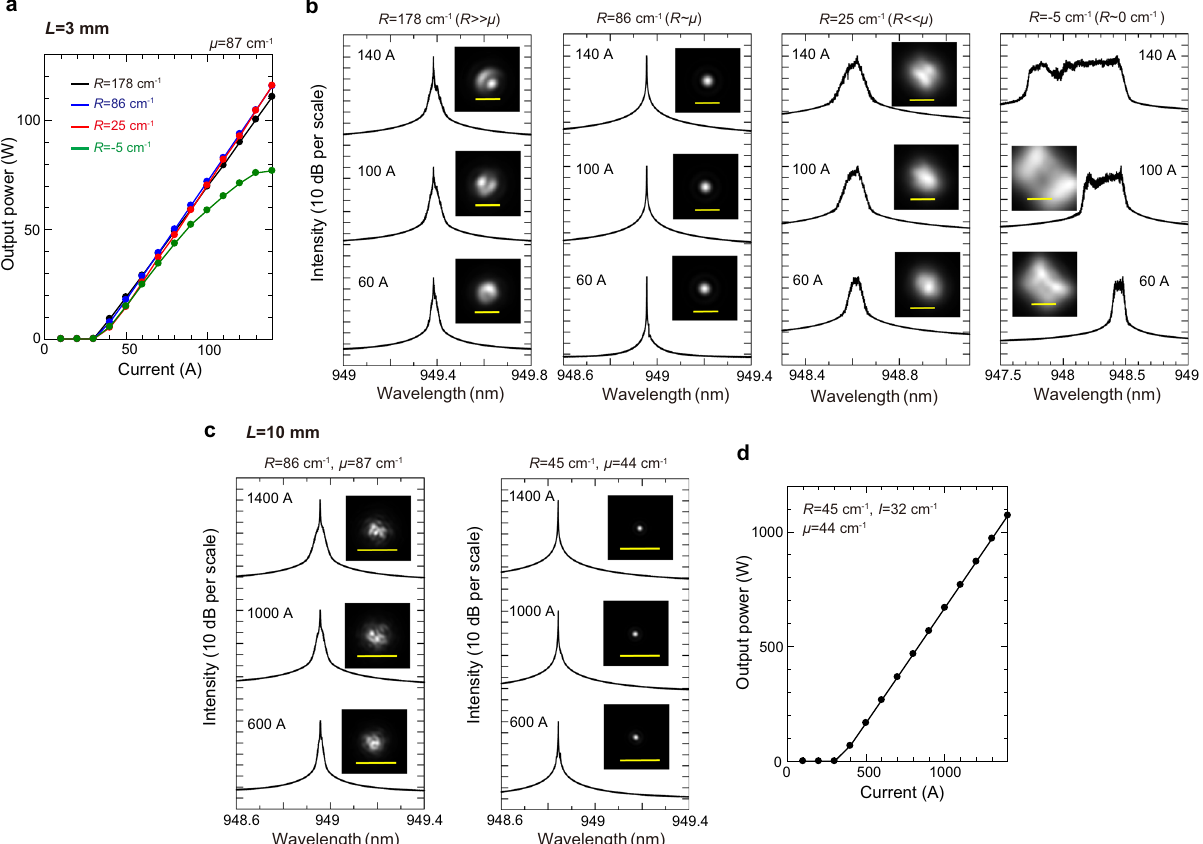
Fig. 6 Numerical demonstration of single-mode lasing in ultra-large-area PCSELs with controlled coupling coef fi cients. a Calculated I - L characteristics of 3-mm-diameter PCSELs with four different lattice separations d or the real part of phase-invariant effective Hermitian coupling coef fi cient R . The p -clad thickness and hole sizes are fi xed [ μ = 87 cm − 1 ]. The values of I for the four devices are 72 cm − 1 (black), 54 cm − 1 (blue), 34 cm − 1 (red), and 34 cm − 1 (green), respectively. b Calculated lasing spectra and far- fi eld beam patterns for the four devices. The yellow bar in each fi gure indicates a divergence angle of 0.05°. When R almost equals μ , single-mode lasing with a nearly diffraction-limited divergence angle is obtained. c Calculated lasing spectra and far- fi eld beam patterns for 10-mm-diameter PCSELs with two different designs: R = 86 cm − 1 , μ = 87 cm − 1 , I = 54 cm − 1 and R = 45 cm − 1 , μ = 44 cm − 1 , I = 32 cm − 1 . The yellow bar in each fi gure indicates a divergence angle of 0.05°. d Calculated I - L characteristic of the latter device ( R = 45 cm − 1 , μ = 44 cm − 1 , I = 32 cm -1 ), which demonstrates the possibility of kW-class single-mode lasing in a centimeter-size